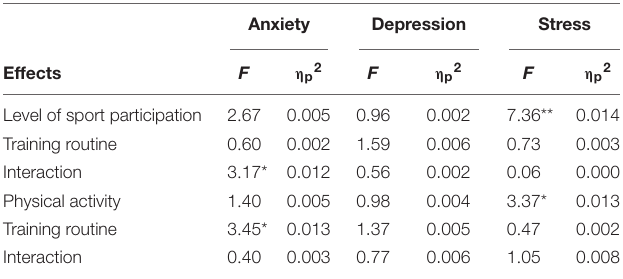
TABLE 4 | Results of two-way ANOVAs: differences in psychological distress regarding the level of sport participation (recreational and elite athletes) and changes in the training routine during the curfew ( N =